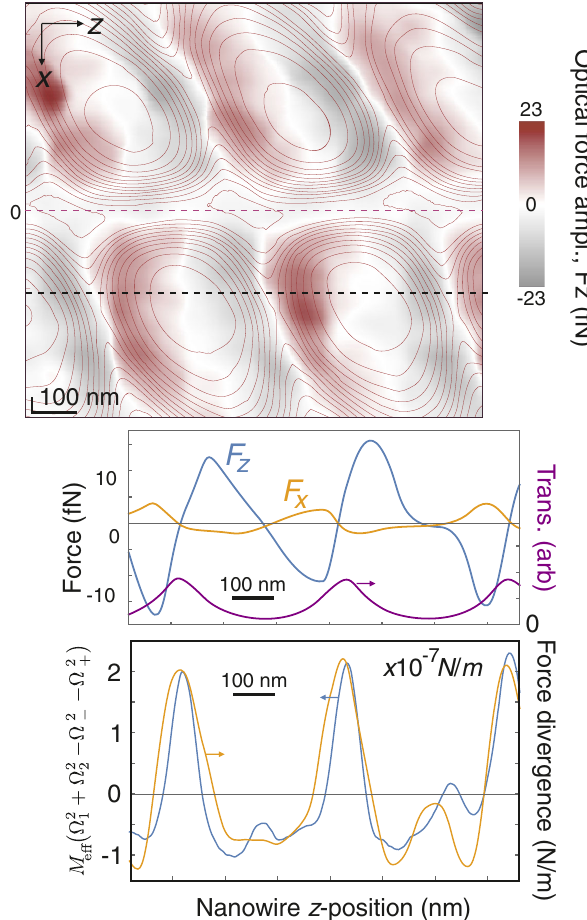
FIG. 11. Optomechanical force field obtained with a TEM 12 mode. Top: multifrequency force-field measurement realized when locking the cavity on a higher-order transverse mode. The map is interpolated from a 400 × 400 measurement grid. The gray lines are isotransmission lines. Middle: cuts along the z direction (dashed line in the map, on the side of the optical axis) of the force components. Bottom: force divergence deduced from mechanical frequency shifts (blue) and spatial derivation of the force map (orange), evaluated along the same cut in the